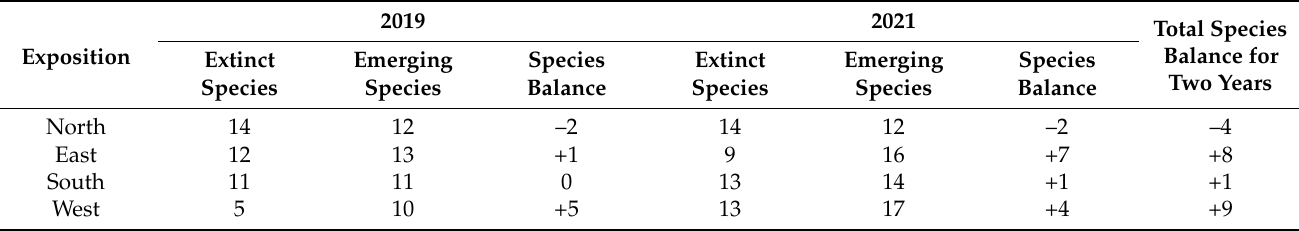
Table 3. The shift in the number of plant species in the segments of the green columns according to the exposition of the